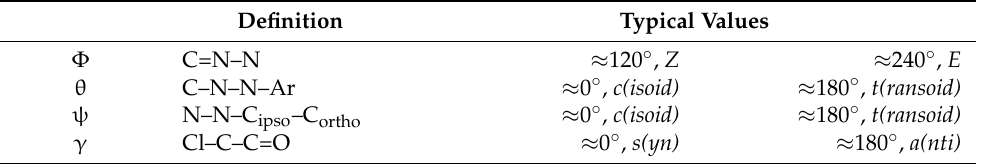
Table 1. Definition of the nomenclature for the chlorohydrazone isomers.